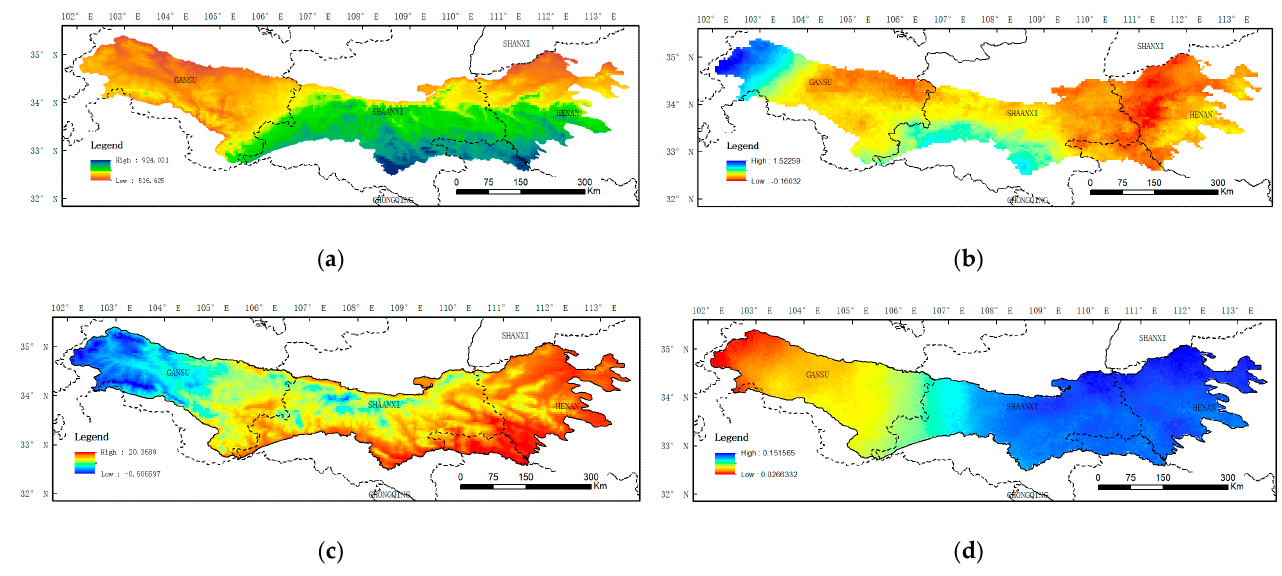
Figure 12. The spatial distribution and change trend of precipitation ( a , b ) and temperature ( c , d ) in Qin Mountains from 1987 to 2019. ( a ) Average precipitation. ( b ) Precipitation change trend. ( c ) Average temperature. ( d ) Temperature change trend.